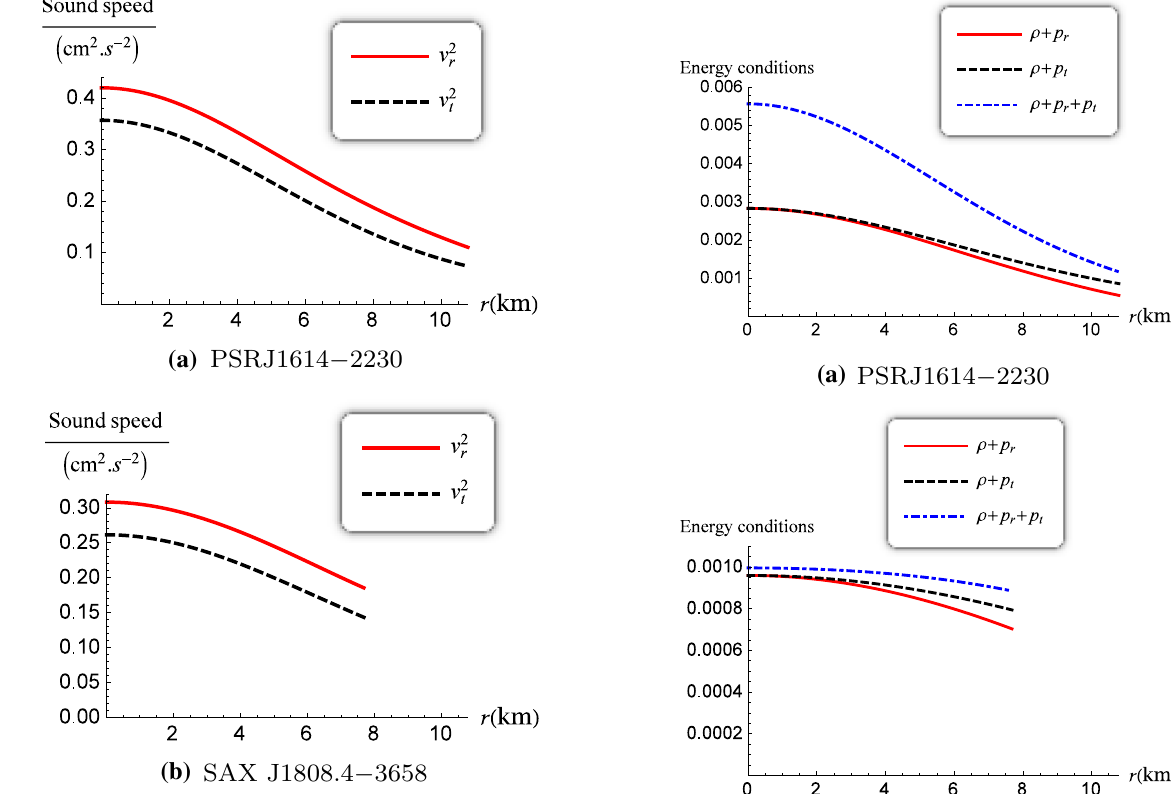
Fig. 5 Variation of speed of sound verses the radius